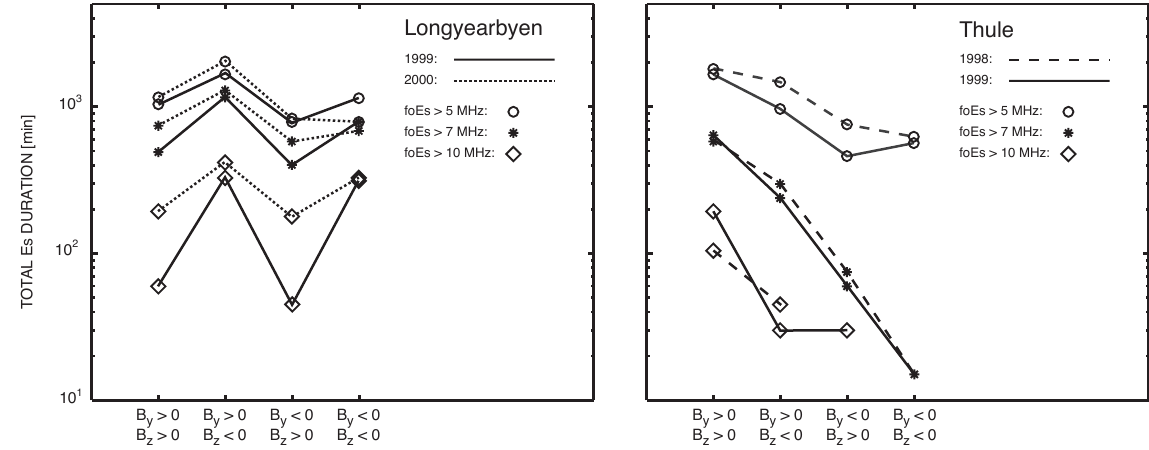
Fig. 5. The total time of Es occurrence at Longyearbyen and Thule when the IMF points in each of the four quardants of the B y B z plane. Separate plots are made for each year and peak plasma frequencies higher than 5, 7 and